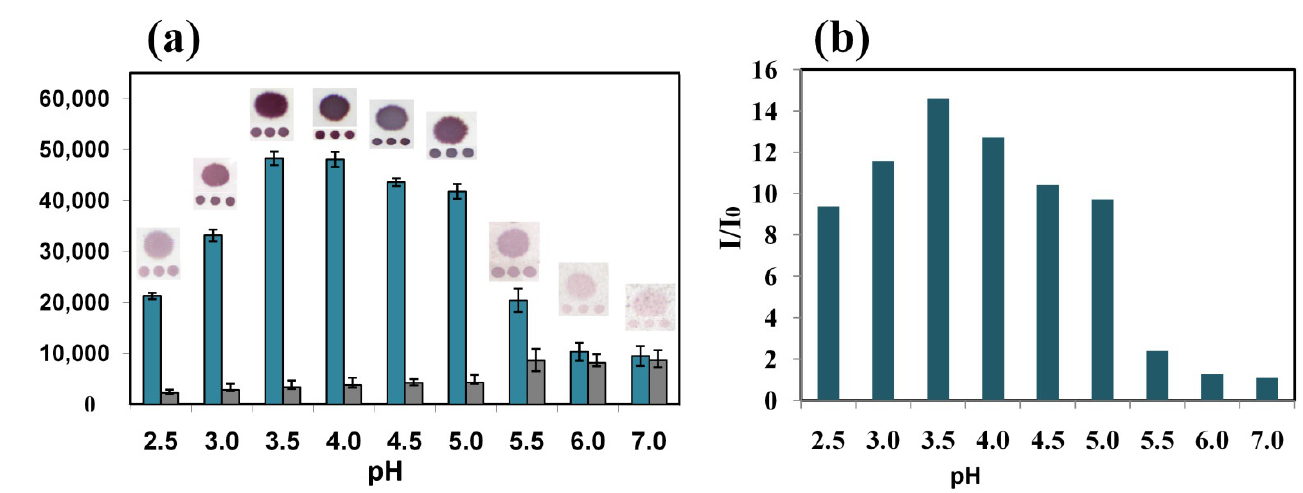
Figure 4. Absolute intensities of staining of specific spots (blue) and areas around the spots (gray) after AuNP enhancement at different pH values ( a ); signal-to-noise ratios at different pH values ( b ). Hybridization of 150 pM of target oligonucleotide.